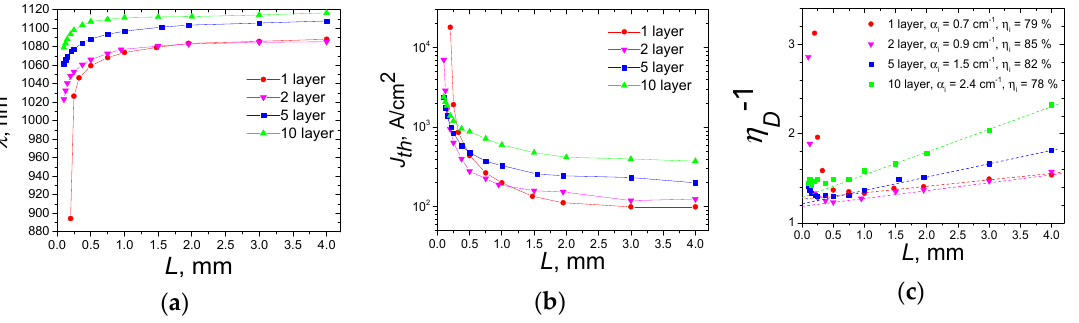
Figure 10. The dependencies of laser characteristics on stripe length for devices with different number of QWD layers: ( a ) lasing wavelength, ( b ) threshold current density, and ( c ) inverse differential efficiency.